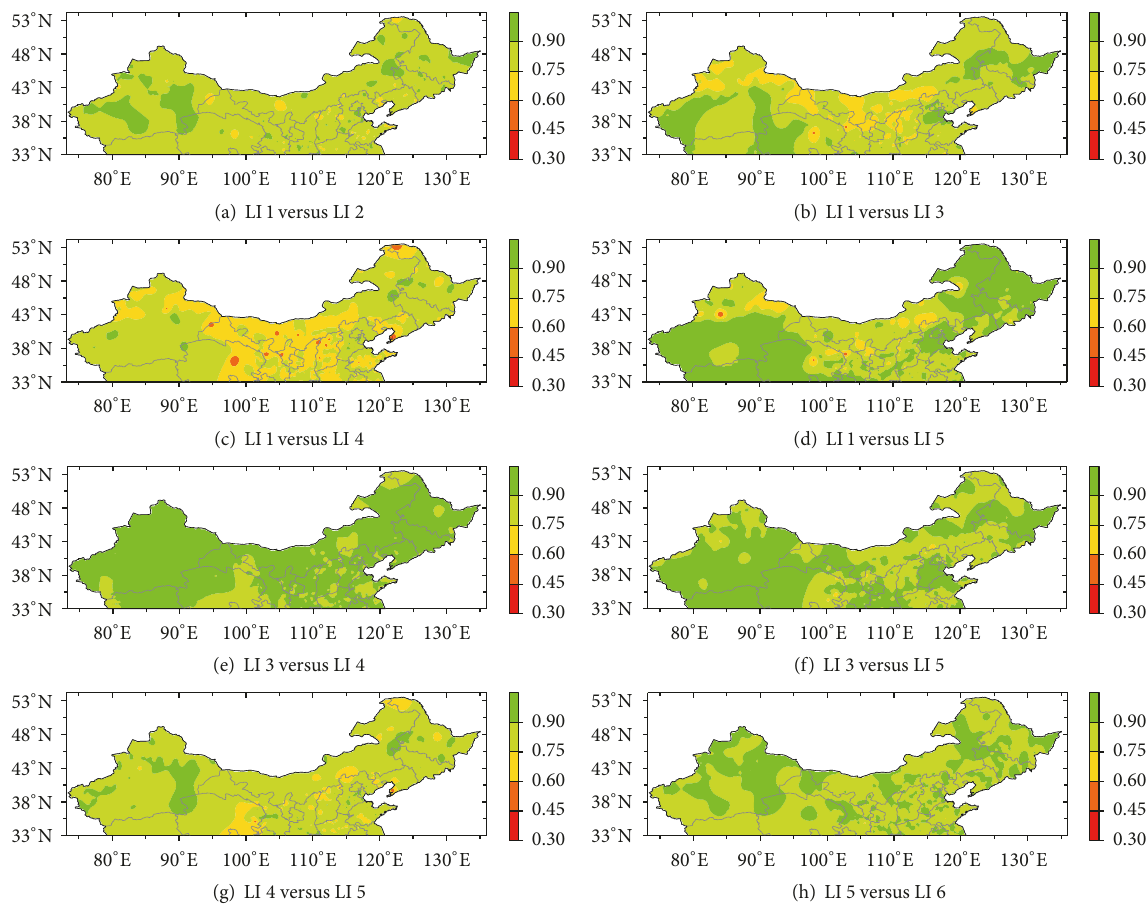
Figure 6: Correlation coefficients for combinations of indices of growing season length in northern